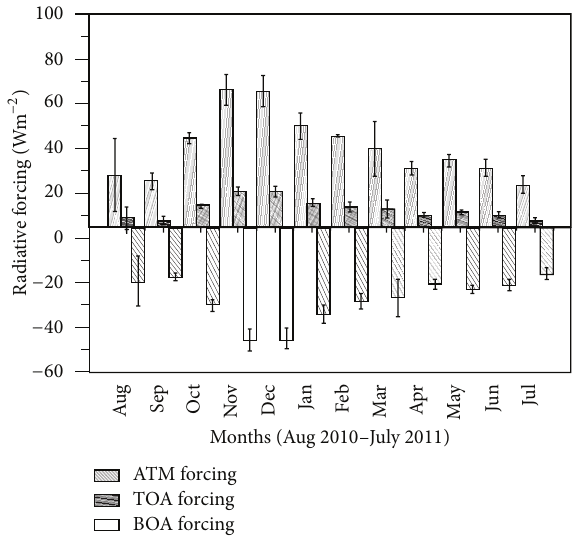
Figure 4: Variation of monthly averages of clear sky BC radiative forcing over TOA, BOA and in the atmosphere from August 2010 to July 2011.